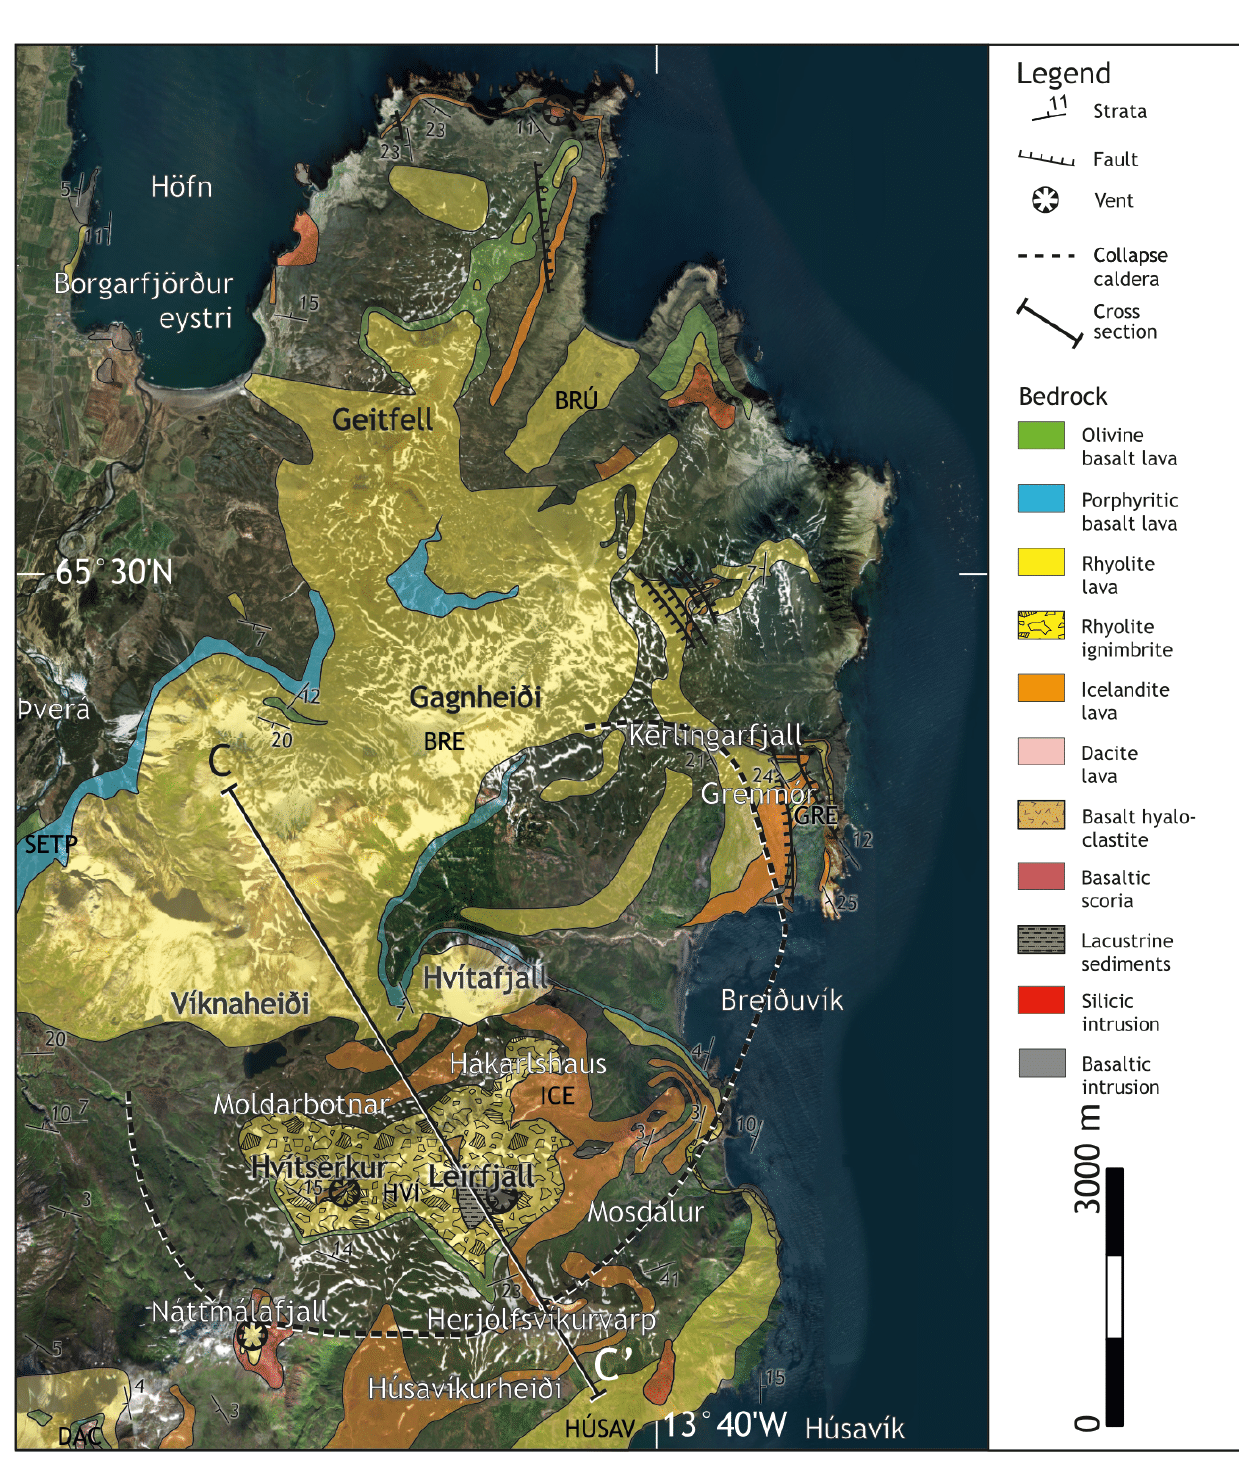
Figure 7: Geological map of the Breiðuvík volcano. For location, see Figure 3. Satellite image from 2009 ac- cessed through Bing Maps ( https://www.bing.com/maps ). For the cross section C–C (cid:48) , see Figure 13. For names of stratigraphic formations, see text and Figure